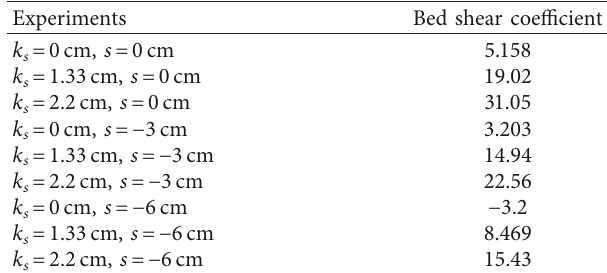
Table 2: The average value of the bed shear coefficient.